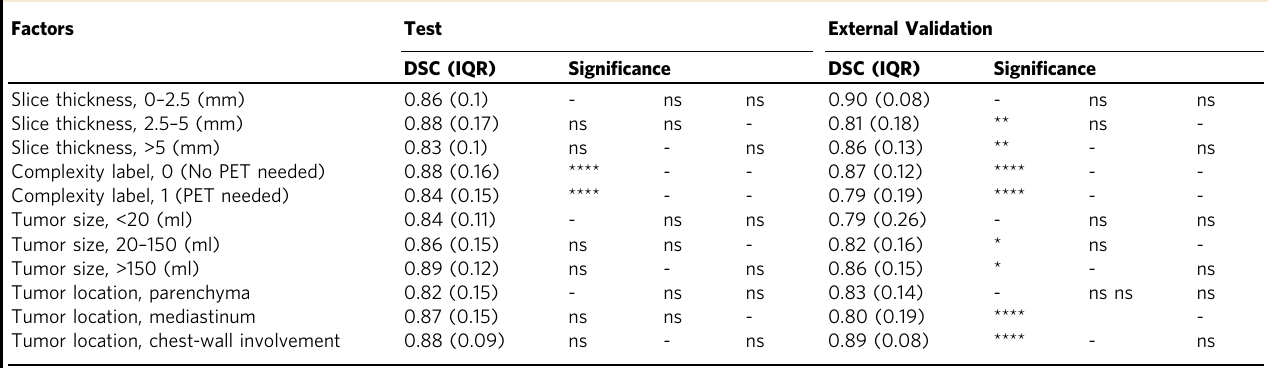
Table 3 Overview of quantitative model performance with regard to various factors. Factors